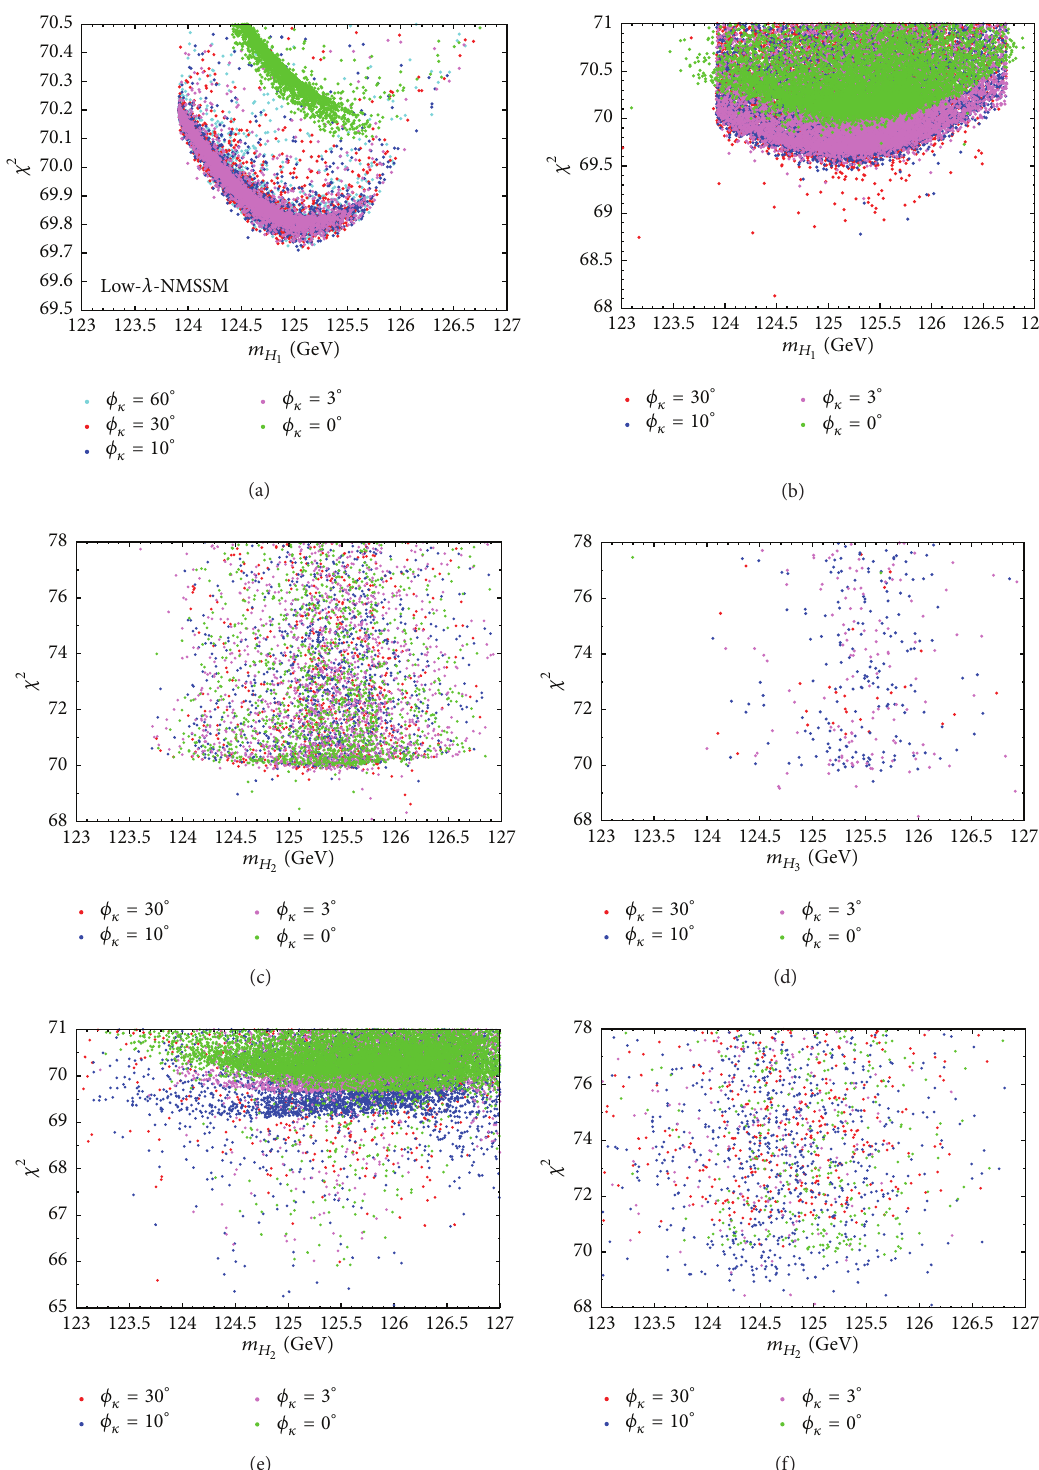
Figure 1: Total 𝜒 2 as a function of the following: ((a), (b)) 𝑚 𝐻 of the parameter space (see text for details); (c) 𝑚 𝐻 lie near 125 GeV; and (f) 𝑚 𝐻